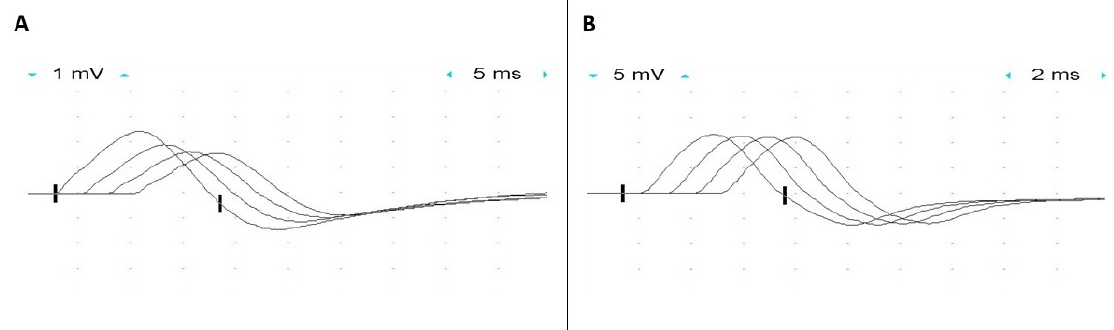
Figure 2. Electrophysiologic studies of a patient with GMPPB limb-girdle muscular dystrophy who had intermittent exacerbations of weakness and fatigable proximal muscle weakness. Low frequency (2 Hz) repetitive nerve stimulation demonstrated ( A ) a 35% decrement in compound muscle action potential amplitude in the trapezius upon stimulation of the spinal accessory nerve while ( B ) no decrement was observed in the abductor digiti minimi upon stimulation of the ulnar nerve. (Courtesy of Dr. Eric Sorenson and Ms. H. Ouelette).